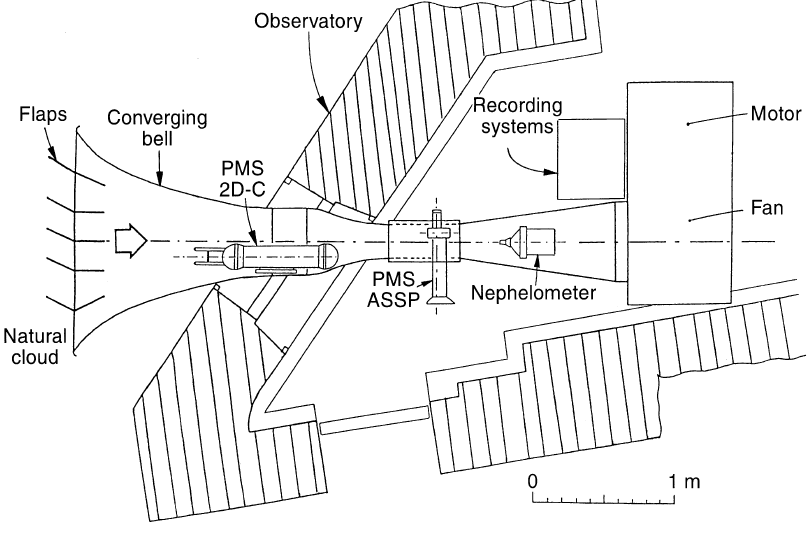
Fig. 1. Sketch of the wind tunnel operated at the summit of the Puy de Doˆ me mountain (1465